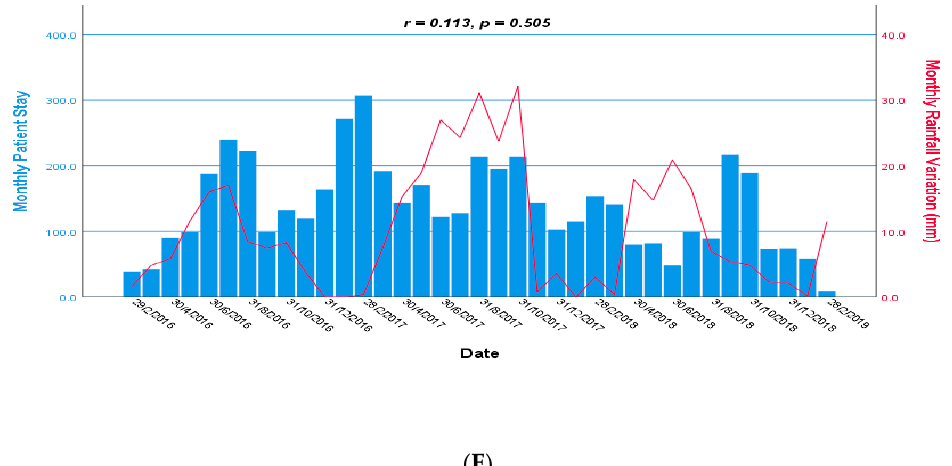
Figure 3. Monthly time series: average temperature ( A ), temperature variation ( B ), average humidity ( C ), humidity variation ( D ), average rainfall ( E ), and rainfall variation ( F ) during the hospital stay of the children with severe pneumonia from 2016 to 2019. Scale of monthly patient stay in the hospital and climate variables are shown in the left and right axis, respectively.